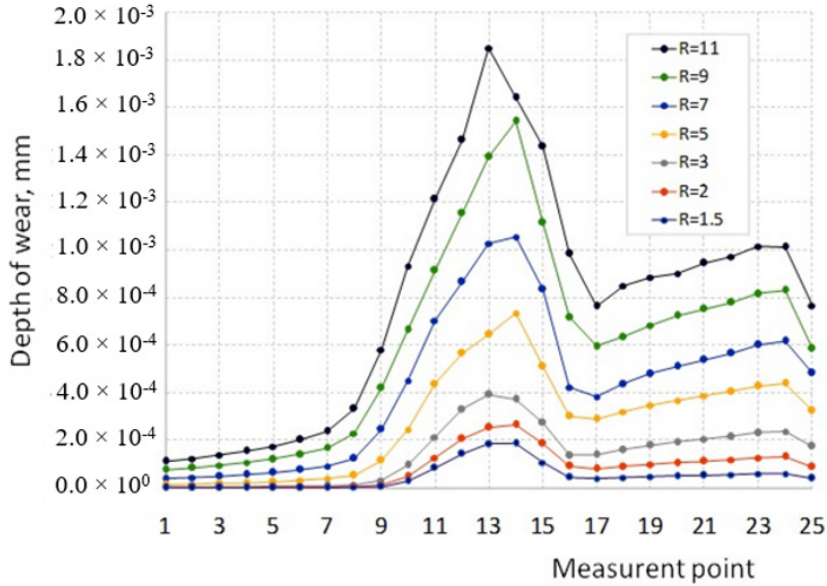
Figure 13. The impact of the extrusion ratio R on the depth of die wear in the measuring area. Within all tested values of the R ratio, the smallest wear occurs in the area of the corner on the face of the die, and its depth increases in the direction of the radius of the die corner (points 1 to 8). However, the largest wear depth is in the corner of the die (points 9 to 15), and the maximum wear depth lies in the center of this radius (points 13 and 14). The depth of the wear in the area of the calibration strip (points 16 to 25) is definitely greater than on the front face but is correspondingly smaller than on the die radius. In all measuring areas (points from 1 to 25), the wear depth increases as the R value increases. At the same time, the increase in wear depth is not proportional to the value of the R ratio but increases more with the higher the value of this ratio. In other words, in the R ratio range from 1.5 to 3, the increase in wear depth is not as intense as, e.g., in the R ratio range from 3 to 11. For example, while maintaining the same input material parameters, increasing the R ratio from 1.5 to 3 results in a more than two-fold increase in the maximum wear depth. However, increasing the R ratio from 3 to 7 causes a more than 2.5-fold increase in the depth of tool wear. On the other hand, when the R increases from 3 to 11, the maximum